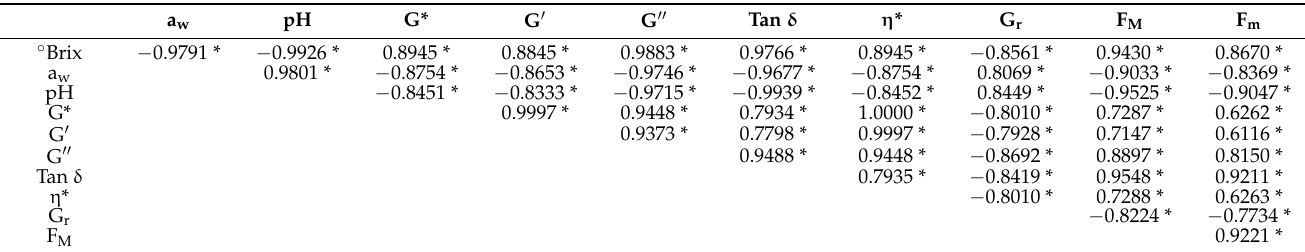
Table 3. Pearson correlation coefficients among ◦ Brix, aw, pH, rheological parameters (G*, G (cid:48) , G (cid:48)(cid:48) , Tan δ , and η *), and extrusion parameters (G, F M , and F m ) of